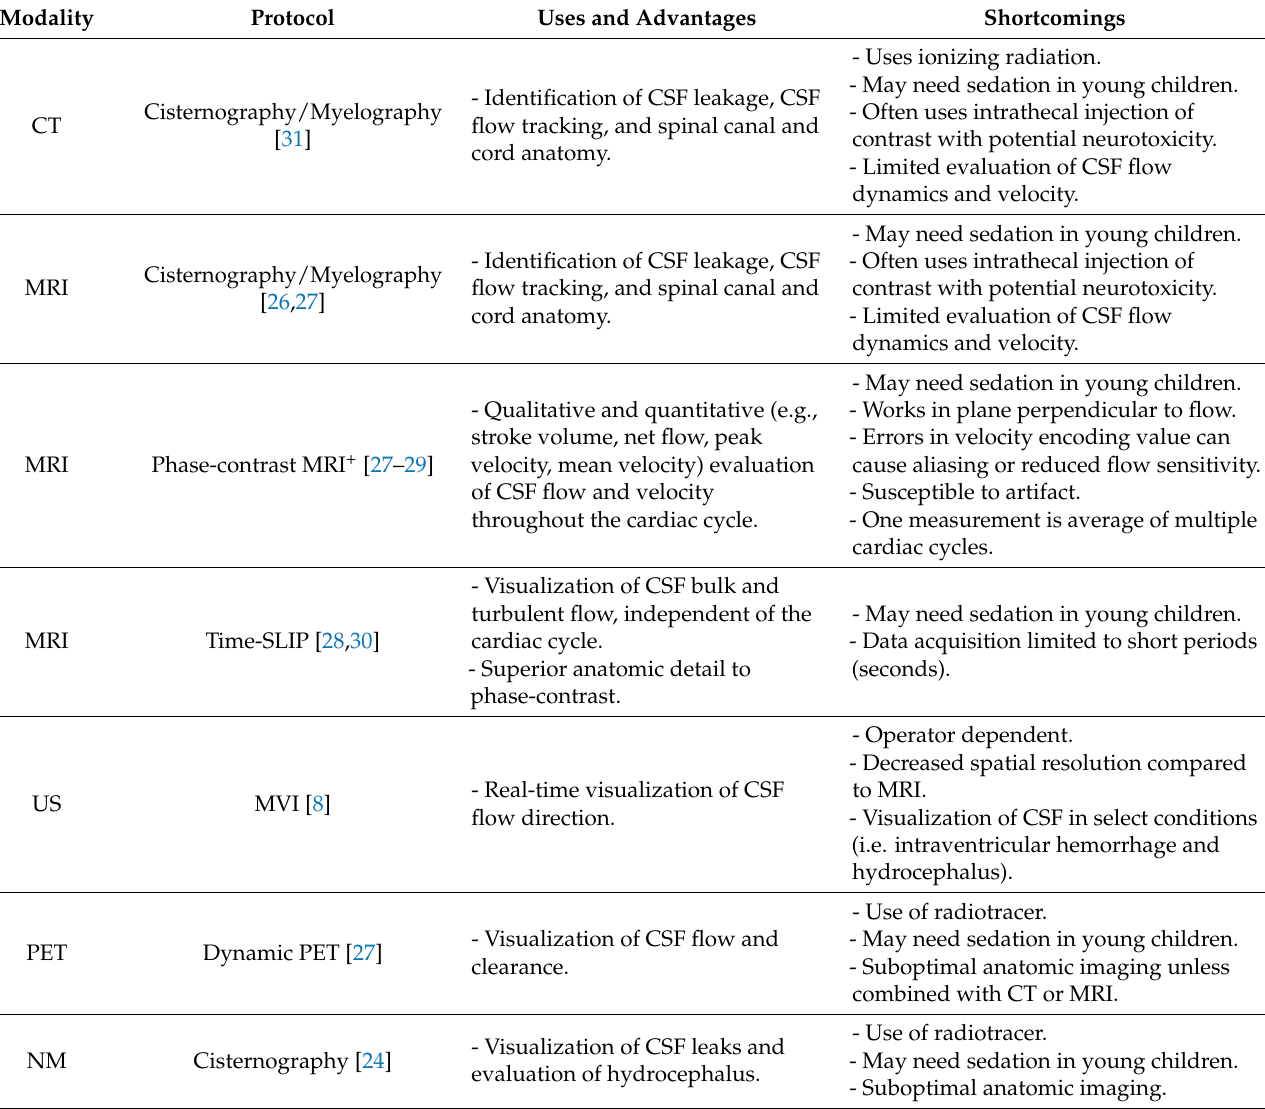
Table 3. Current and emergent imaging protocols used for the evaluation of cerebrospinal fluid